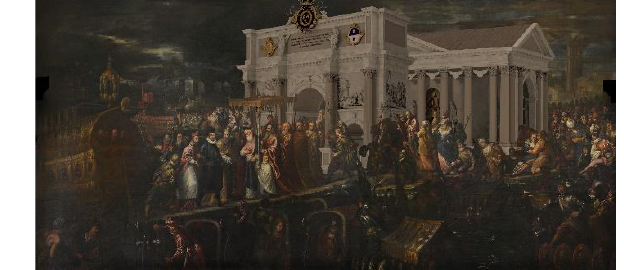
Figure 7. Photomontage of the 3D models inside the painting.